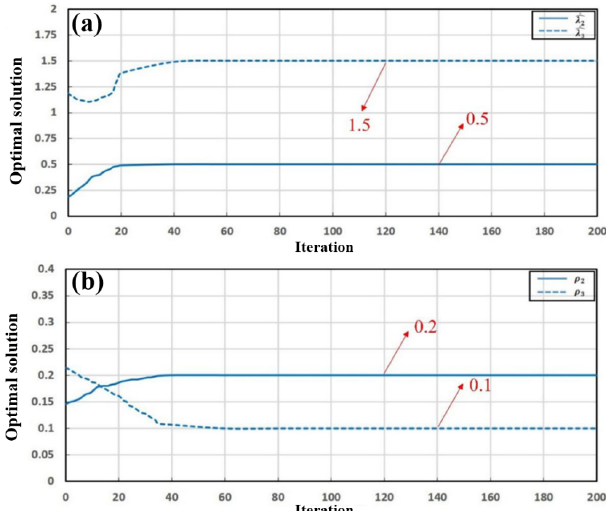
Figure 1. The 3D EVC system. (a) Model structure of 3D EVC. (b) Schematic diagram of the 3D EVC.